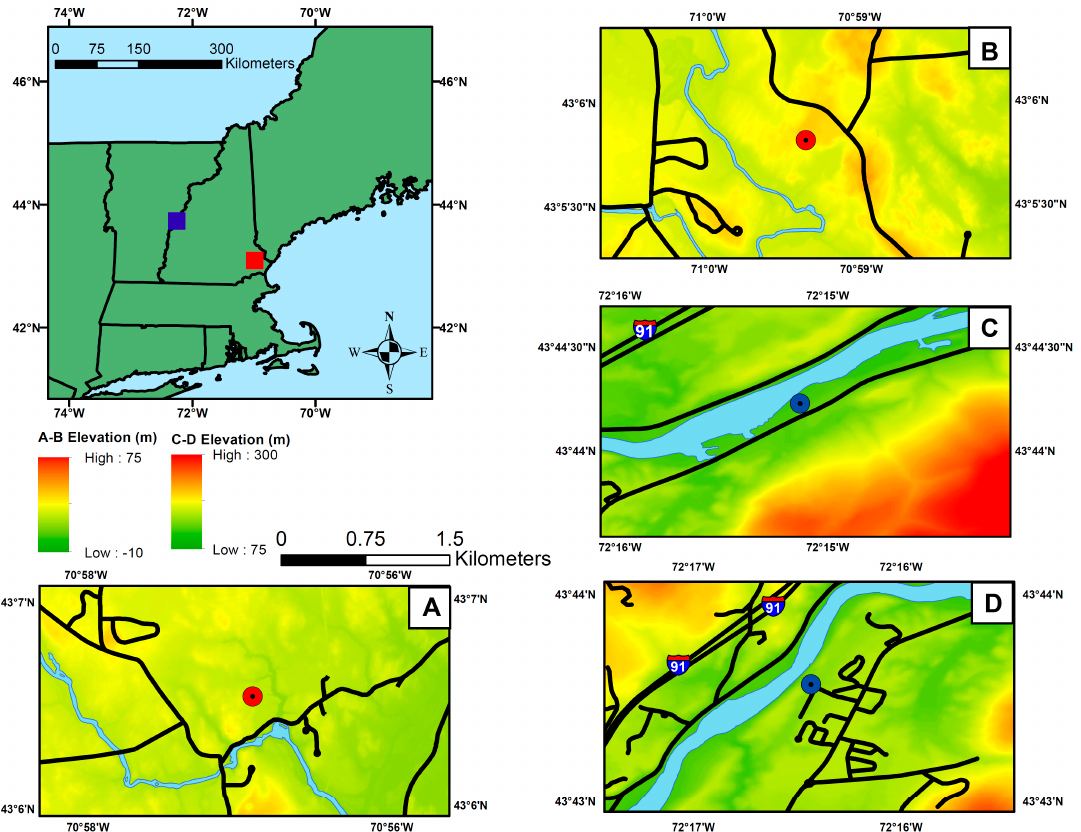
Figure 1. A map of TFO (panel A ), BDO (panel B ), DFO (panel C ) and CYO (panel D ) in relation to the nearest roads. Each site location in panels A – D is color coded to its location within New Hampshire in the broader region shown (upper left). CYO was located near the CRREL yard drive, but the nearest public road is 290 m away.